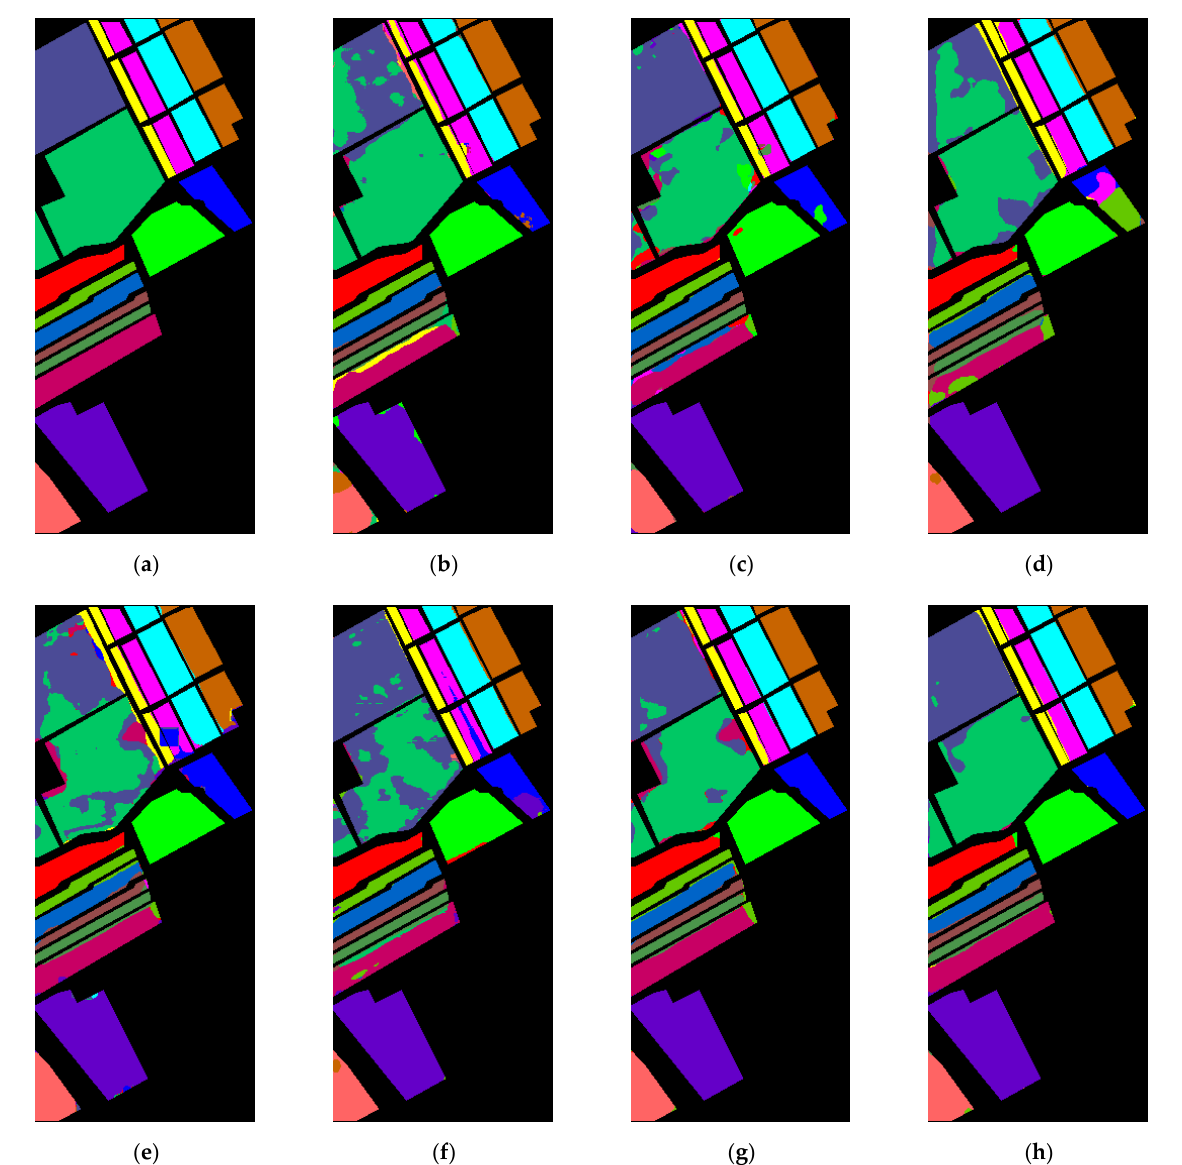
Figure 14. Classification maps for SA dataset. ( a ) Ground-truth map; ( b ) 3D-CNN; ( c ) HybridSN; ( d ) SSRN; ( e ) MCNN-CP; ( f ) A 2 S 2 K-ResNet; ( g ) Oct-MCNN-HS; ( h ) proposed method.